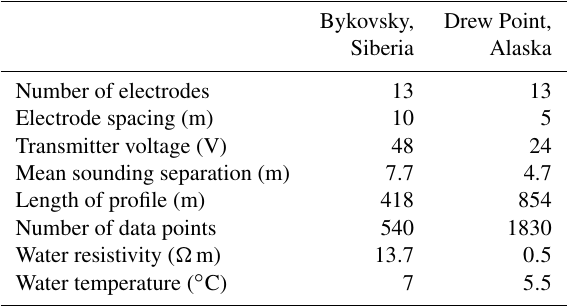
Table 1. Acquisition parameters for our ERT data sets and further site-specific information for our two field sites. Bykovsky, Drew Point, Siberia Alaska Number of electrodes